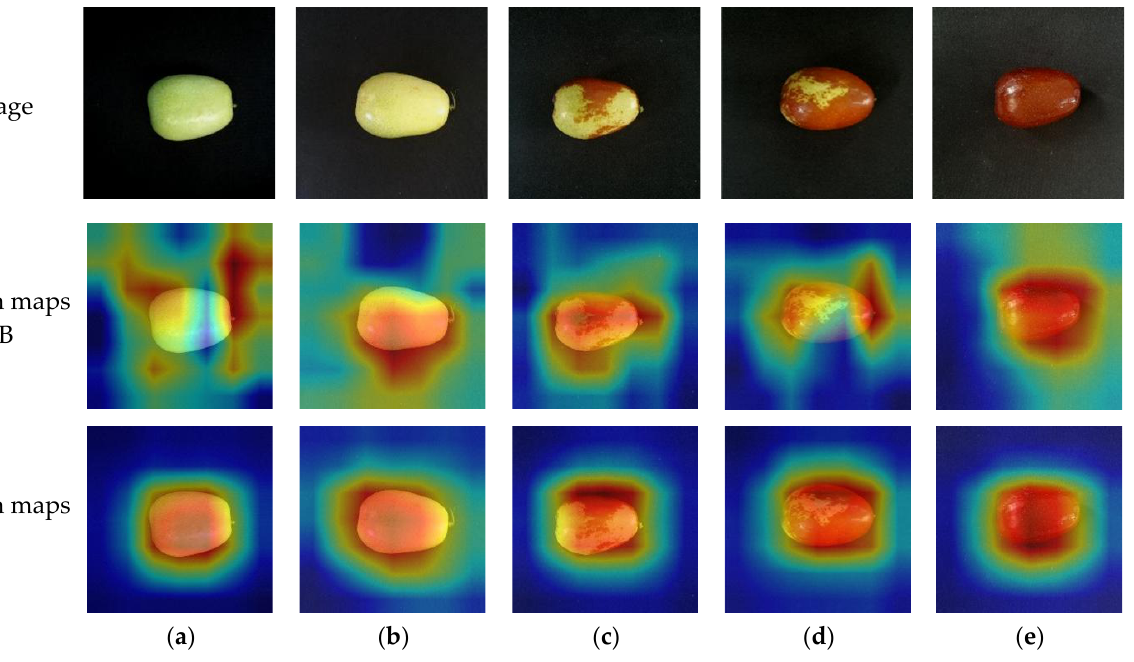
Figure 9. Examples of class activation maps for the model before and after adding the class balance term: ( a ) immaturity; ( b ) white maturity; ( c ) early-red maturity; ( d ) half-red maturity; ( e ) full maturity.